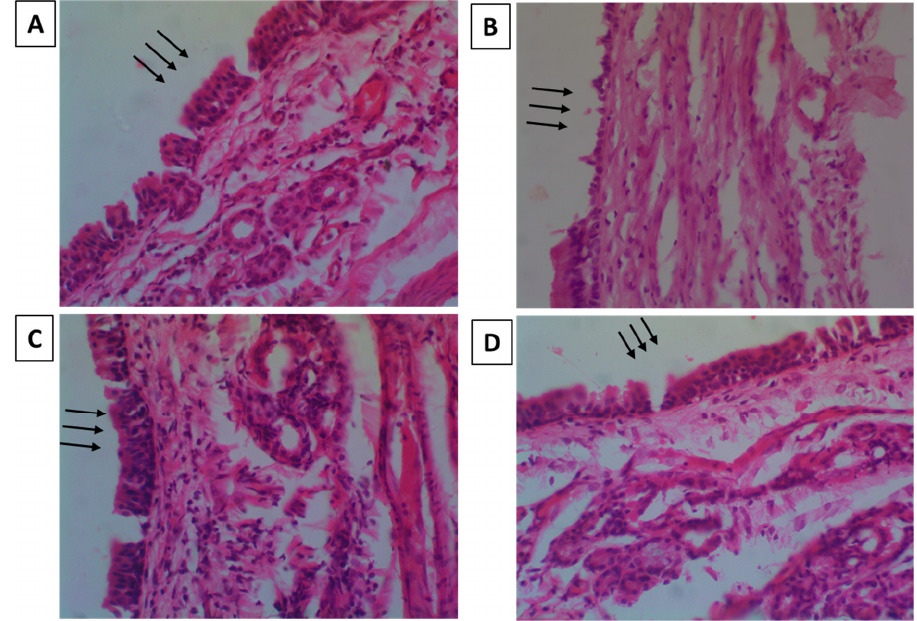
Figure 5. Microscopic images showing nasal ‐ cilia toxicity of ( A ) negative control (arrows indicating intact mucosa); ( B ) positive control (arrows indicating damaged mucosa); ( C ) ZTP solution (arrows indicating intact mucosa); and ( D ) ZTP ‐ ME (arrows indicating intact mucosa).